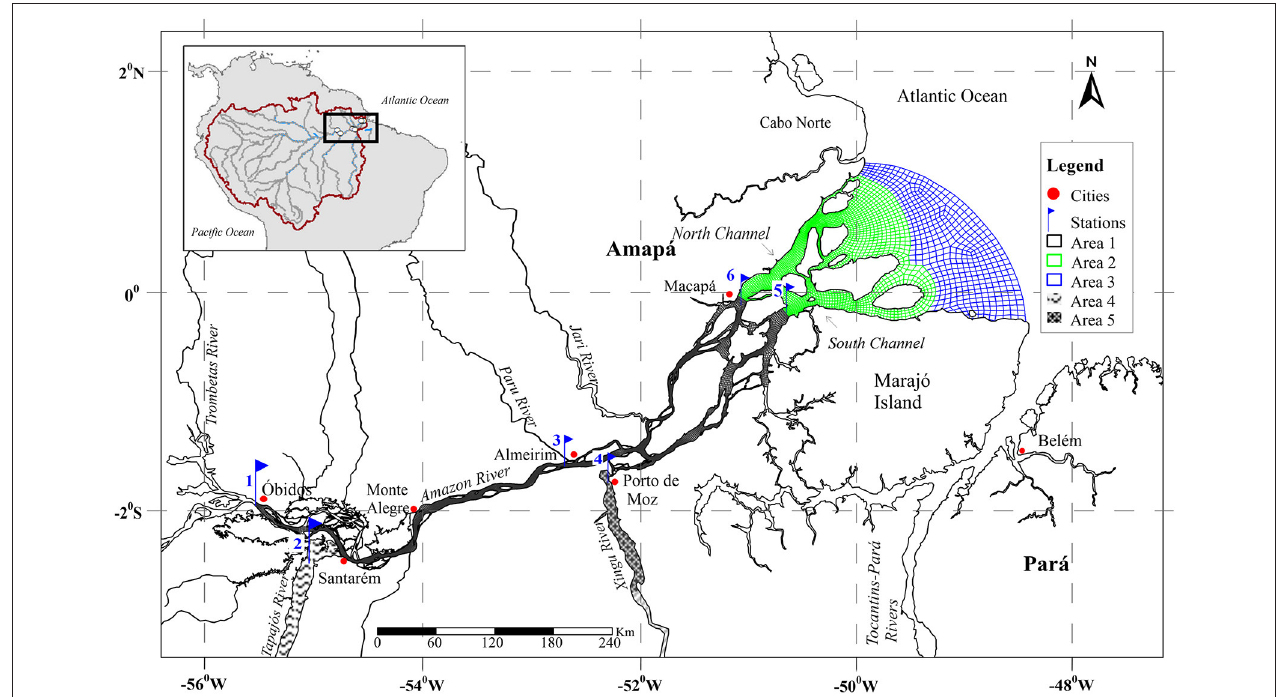
FIGURE 1 | Lower Amazon River showing the sampled stations and the mainstem river areas